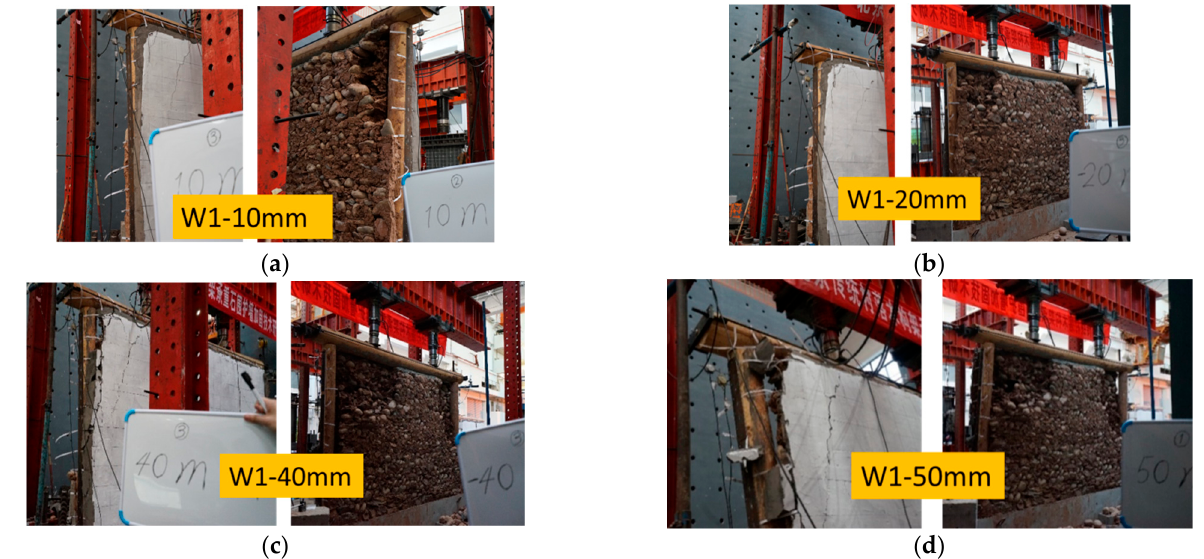
Figure 12. Displacement loading for W1: ( a ) 10 mm, ( b ) 20 mm, ( c ) 40 mm, and ( d ) 50 mm. For specimen W2 with a PP band mesh grid of 150 mm × 150 mm, at a loading displacement of 20 mm, a few stones fell at the corners of the unreinforced side and the mortar surface bulged, with multiple cracks appearing at the corners of the reinforced side, similar to W1. At a loading displacement of 30 mm, the reinforced side remained flat, except for a bulge and a deep crack at the corners. Due to the narrow grid size of the PP band mesh, a small amount of mortar fell from the upper end of the column. Meanwhile, a symmetrical collapse of the stones occurred at the corner of the unreinforced side, with a fan-shaped collapse area on the left (Figure 13a). In addition, the lateral force of specimen W2 dropped to below 50% of its maximum capacity. At a loading displacement of 40 mm, the compression from the frame caused detachment at the edge of the double-layer stone wall, and a collapse of the stones was observed on the unreinforced side (Figure 13b). The tension of the PP band mesh and the coating on the reinforced side prevented damage to the reinforced side. The individual PP bands attached to the upper end of the column exhibited tensile fractures.